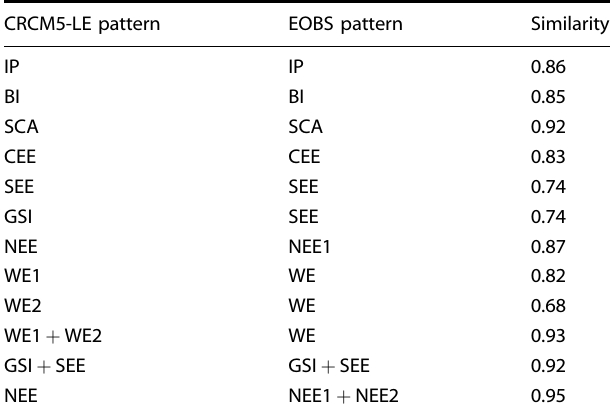
Table 1. E-OBS patterns assigned to CRCM5-LE patterns by the maximum value of cosine